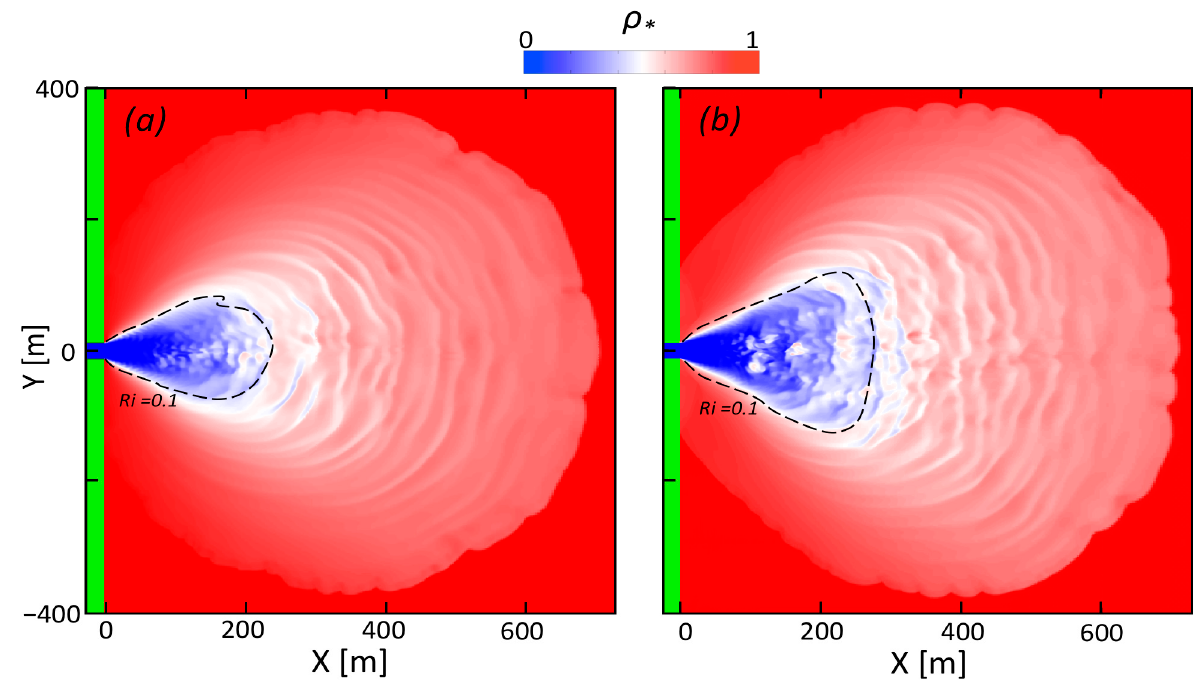
Figure 8. Variation of plume morphology with nearshore bathymetry: ( a ) flat ocean bottom; and ( b ) base case with nearshore slope. Curves indicate values of Richardson number of 0.1. Model time is 1630 s for each case.